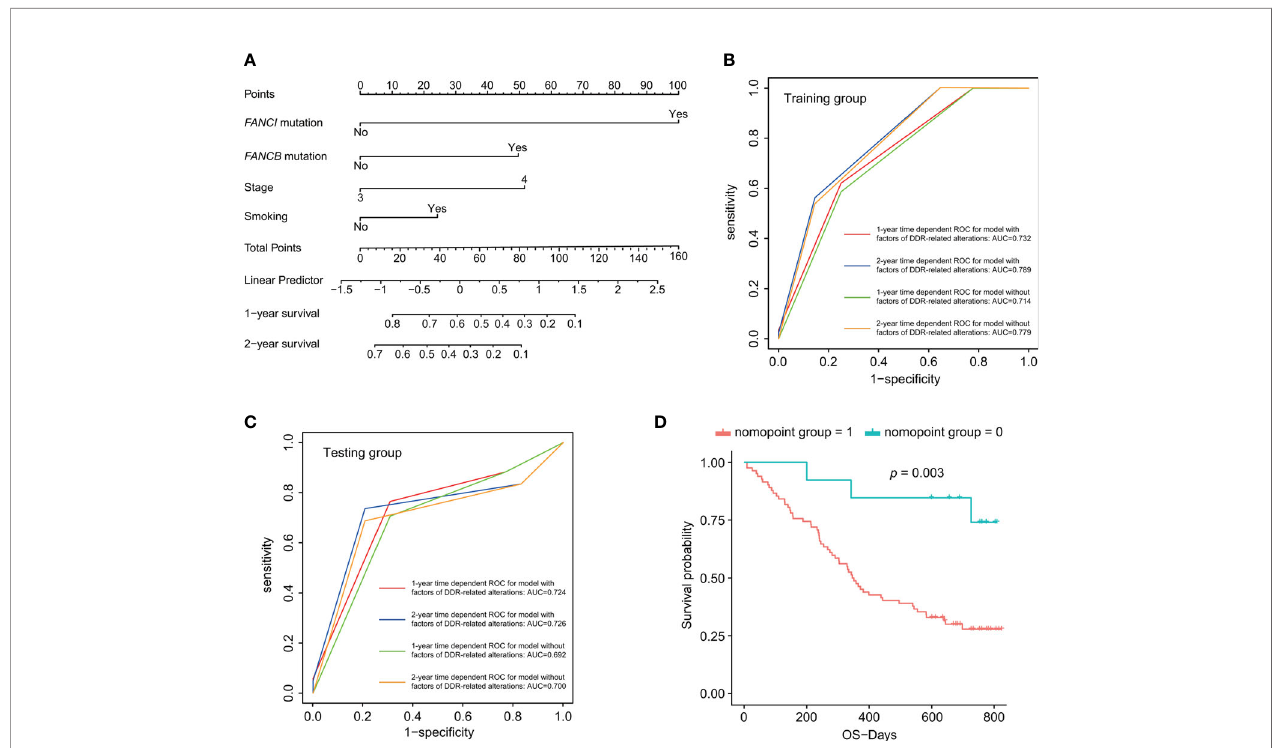
FIGURE 5 | DDR-based risk score construction and predictive nomogram model. (A) Predictive nomogram model incorporating both clinical factors and DDR- related alterations. (B, C) One- and two-year time-dependent ROC curves for prediction model with or without factors of DDR-related alterations. (D) Survival analysis for the nomogram model. p < 0.05 was de fi ned as statistically signi fi